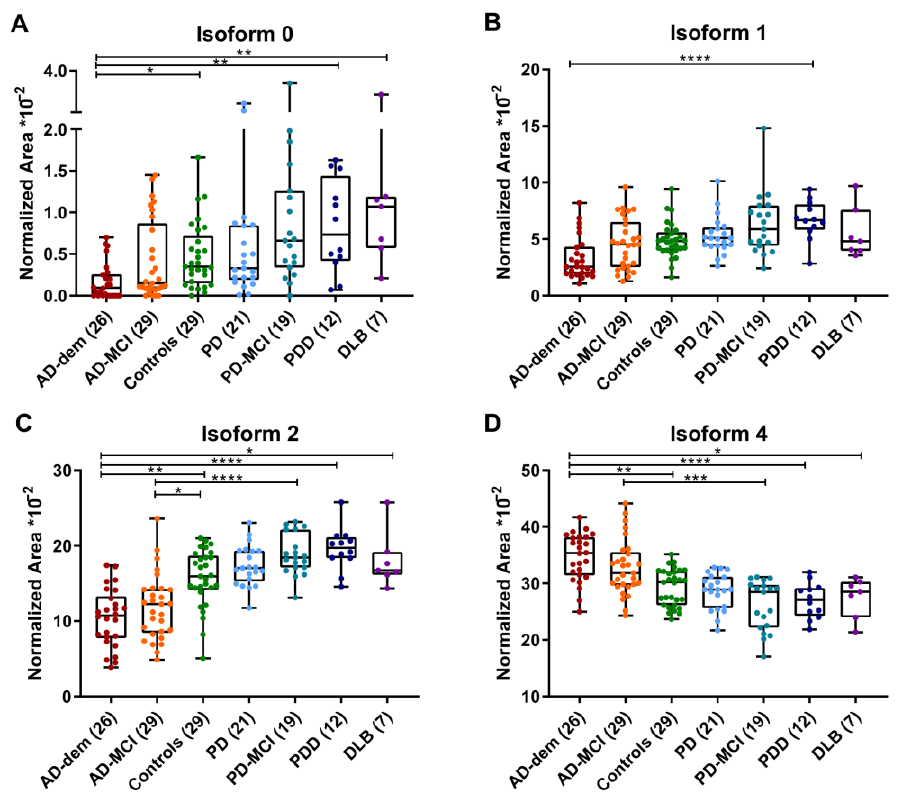
Figure 3. Relative expression of serpinA1 isoforms 0, 1, 2 and 4 among diagnostic subgroups. ( A – D ) Comparison of the relative expression of serpinA1 isoforms in controls, AD-MCI, AD-dem, PD, PD-MCI, PDD and DLB. Box plots indicate median value, interquartile range and range of values. * p < 0.05, ** p < 0.01, *** p < 0.001, **** p < 0.0001. Abbreviations. AD-dem: Alzheimer’s disease with dementia; AD-MCI: Alzheimer’s disease with mild cognitive impairment; DLB: dementia with Lewy bodies; PD: Parkinson’s disease; PDD: Parkinson’s disease with dementia; PD-MCI: Parkinson’s disease with mild cognitive impairment.